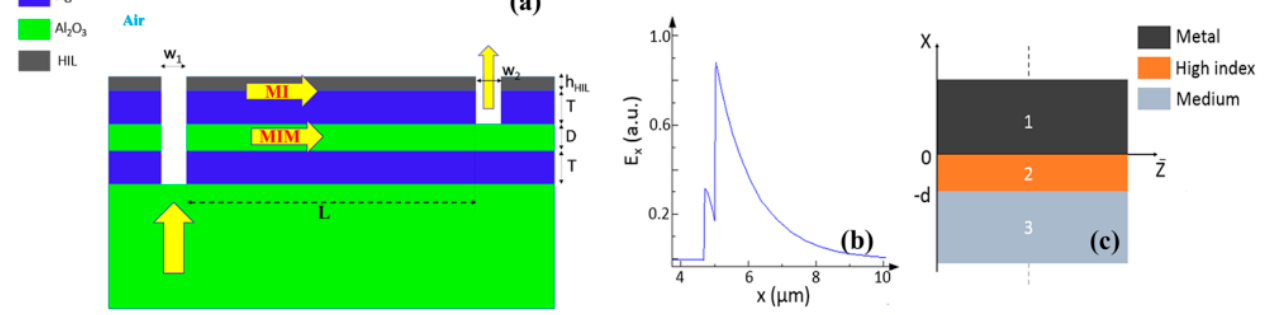
Figure 11. Vertical plasmonic gas sensor MZI with high index layer (HIL) ( a ) structure such that h(HIL) is the high index layer, T is the metal thickness, D is the insulator thickness, w 1 is the width of the input slot, and w 2 is the width of the output slot, ( b ) MII waveguide mode major component E x with silver and HIL with index 2.4 and thickness 320 nm at λ = 4.5 µ m with metal/HIL interface at x = 4.7 µ m, ( c ) MII waveguide [115].